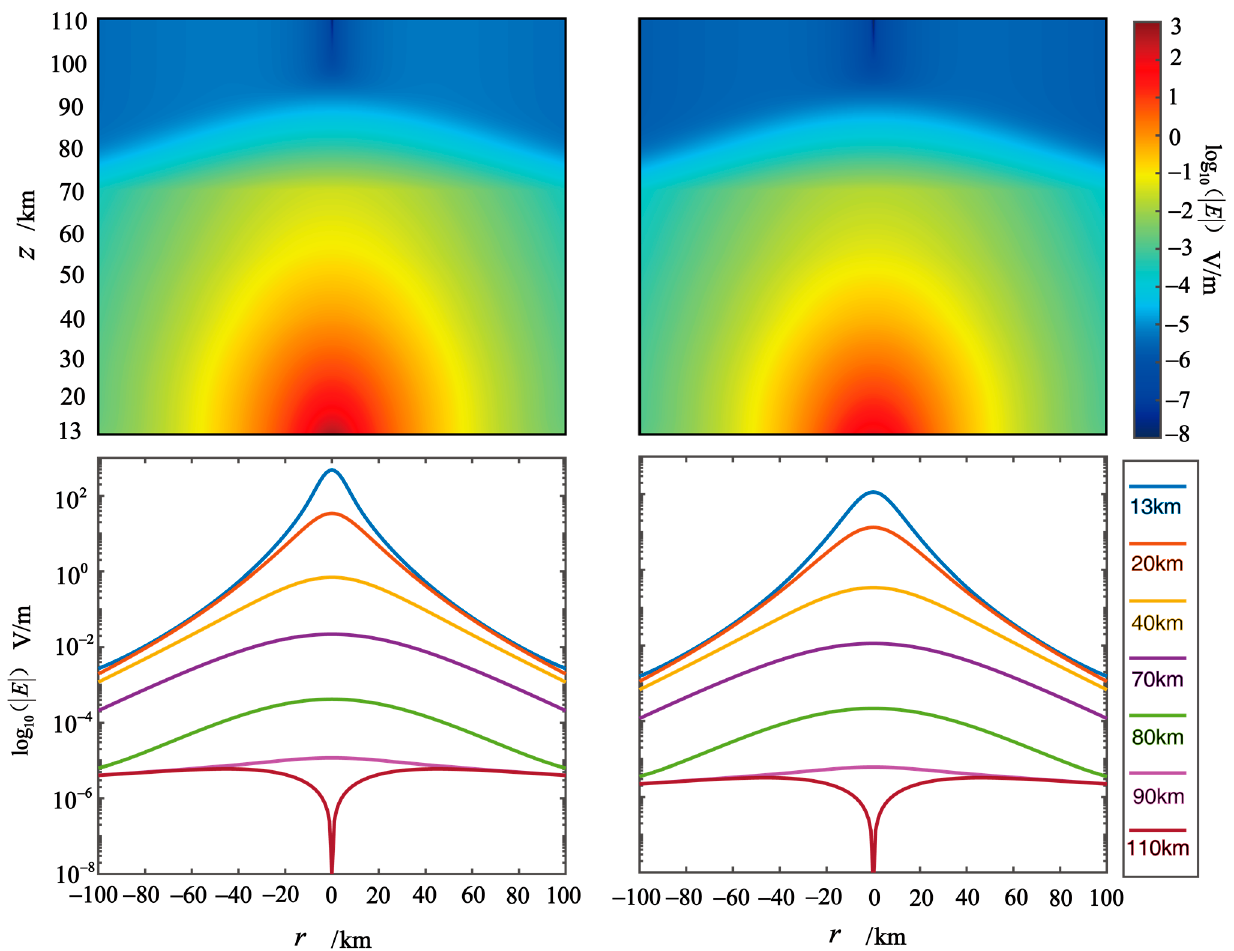
Figure 2. ( Top ) On the left is the electric field intensity distribution induced by a thundercloud with a charge of 1 C centered at 10 km. On the right is the distribution of the total electric field intensity induced by a thundercloud with a charge of 1 C centered at 5 km. ( Bottom ) Plot of electric field intensity versus horizontal distance r at selected altitudes of 13, 20, 40, 70, 80, 90, and 110 km. The center of the left panel is at an altitude of 10 km, and the center of the right panel is at an altitude of 5 km.